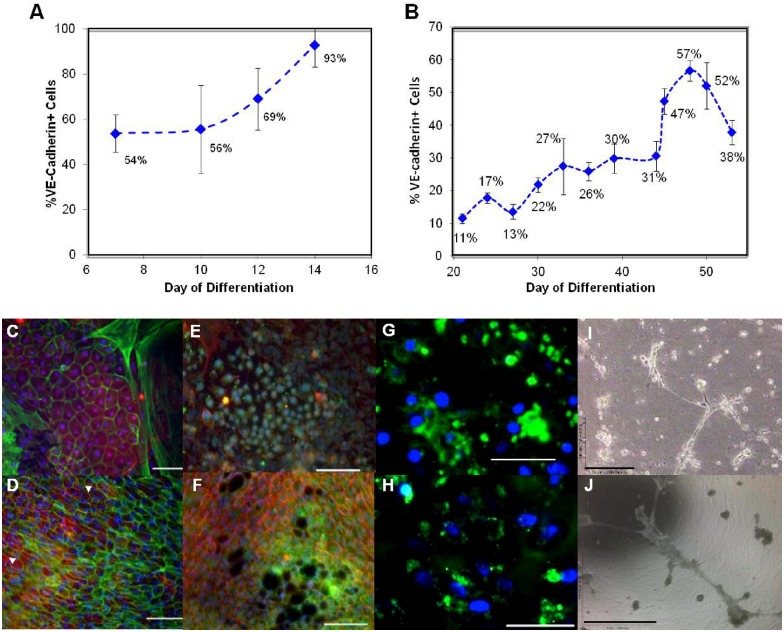
EC Maturation Over Time.After stage 2 induction of Flk-1/KDR+ VPC into VE-cad+ EC, the cells were cultured for longer periods in order to examine further maturation and/or self-purification. Averaged percentages of VE-cadherin+ for both mouse A) and human cells B) are given. A) The mESC-A3 were expanded on fibronectin at 10,000 cells/cm2 with 10 ng/mL VEGF and 10 ng/mL bFGF. The mESC-A3 grew to a purity of 93% VE-cadherin by day 14. B) The hESC-H7 were cultured on fibronectin, seeded at a density of 10,000 cells/cm2 with 25 ng/mL VEGF and 50 ng/mL bFGF. The hESC-H7 also increased in expression of VE-cadherin+ cells, peaking at a 57% by day 48 of total induction (14 days in stage 1 followed by 34 days in stage 2). C, G, E, I) Unpurified mESC-R1 derived EC D, F, H, J) hESC-H7 derived EC express markers and morphology consistent with EC phenotype: C-D) VE-cadherin (red) counterstained with phalloidin (green) and E-F) PECAM-1 (green) counterstained with phalloidin (red) Nuclei stained with DAPI (blue). Large mesenchymal-like cells are seen surrounding the murine cells in C). The mESC-A3 and hESC-H7 also (G-H) took up acetylated LDL and (I-J) formed vascular-like structures in Matrigel™ within 24 hours.